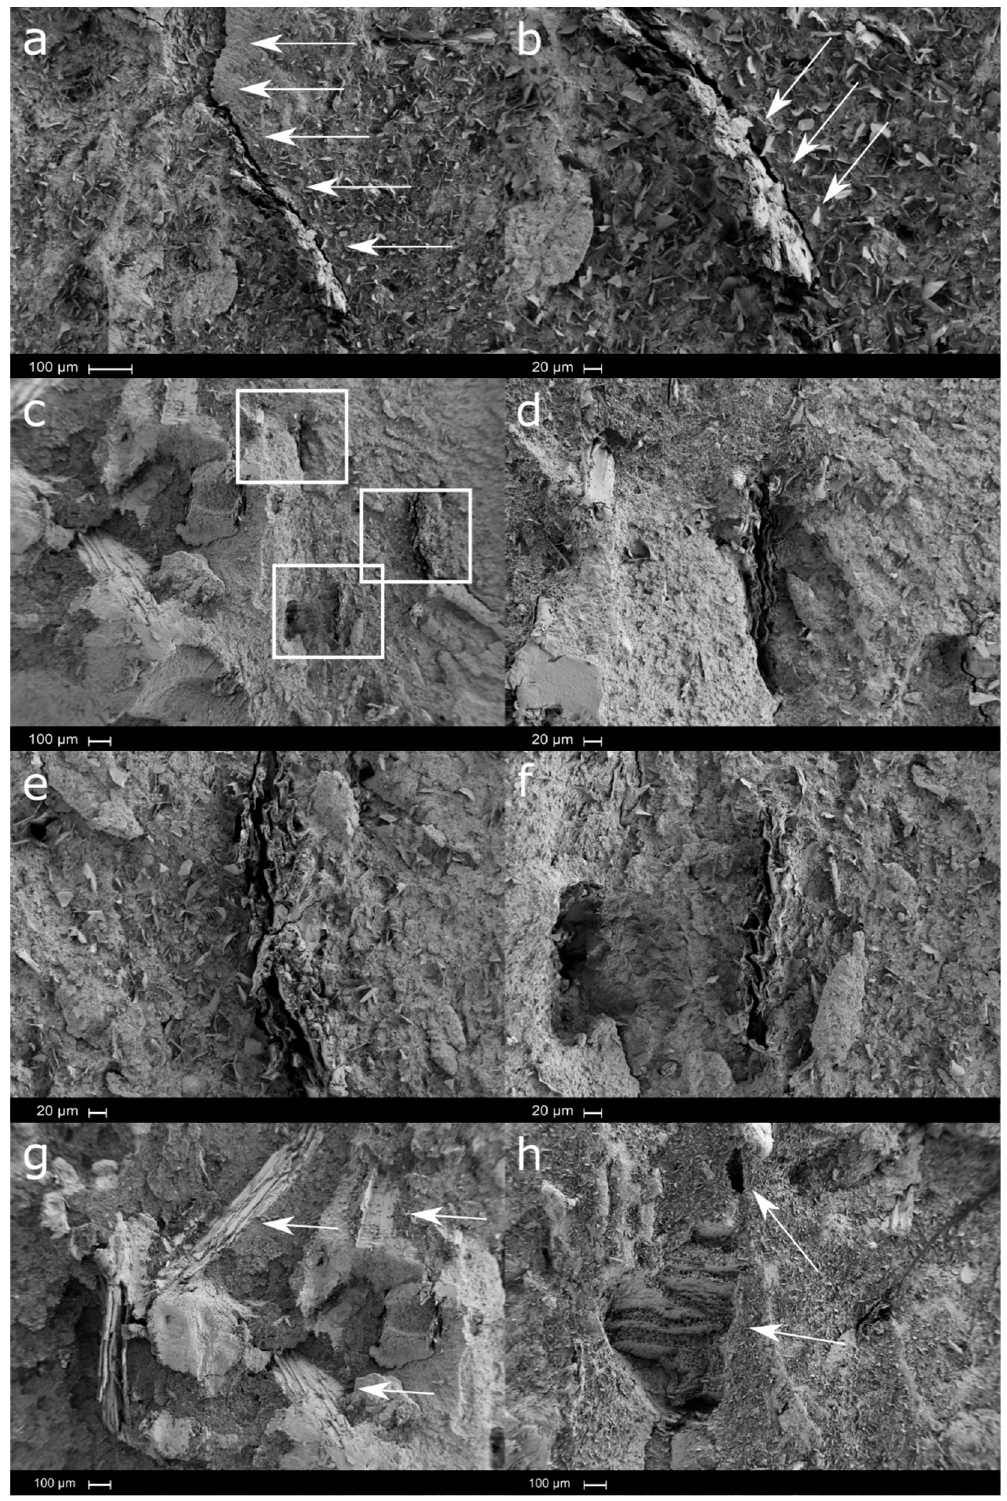
Figure 11. SEM micrographs of medium size particles—10 wt.% wood flour: ( a ) ×100, ( b ) ×200; 20 wt.% wood flour: ( c ) ×50, ( d ) ×200, ( e ) ×200, ( f ) ×200; 20 wt.% wood flour: ( g ) ×50; and 30 wt.% wood flour: ( h ) ×50.